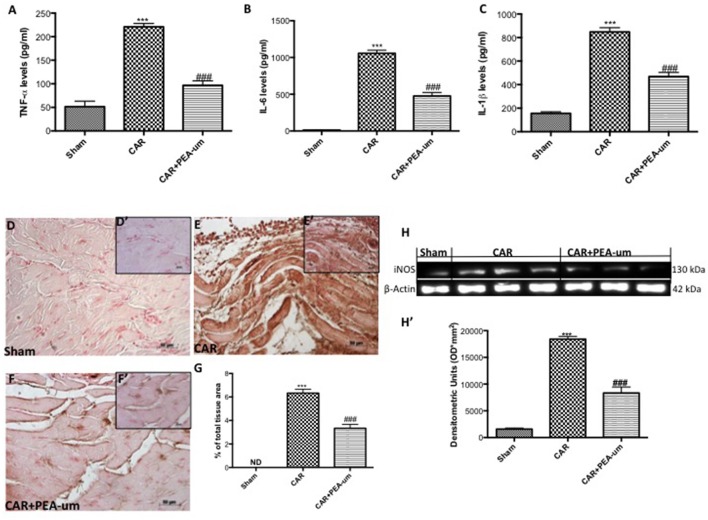
Effect of oral PEA-um on CAR-induced cytokine release, nitrotyrosine formation, and iNOS expression in rat paw tissue. A significant increase of TNF-α (A), IL-6 (B), and IL-1β (C) levels was detected in paw exudates after intraplantar injection of CAR into the rat hind paw. Oral treatment with PEA-um (10 mg/kg) significantly reduced levels of all three cytokines. Immunohistochemical staining for nitrotyrosine was positive in paw tissue sections from CAR-injected rats (E,E',G), as compared to sham animals (D,D',G). The intensity of nitrotyrosine staining was significantly reduced after oral treatment with PEA-um (F,F',G). A significant increase of iNOS expression was observed in paw tissue from CAR-injected rats (H,H'), as compared to sham-treated rats (H,H'). Oral treatment with PEA-um significantly reduced iNOS expression (H,H'). A representative blot of lysates obtained from five animals for each group is shown, and densitometric analysis of all animals is reported. The figures are representative of at least three independent experiments and for all animals from each group. Values are means ± SEM of five animals for each group. ###P < 0.001 vs. CAR; ***P < 0.001 vs. sham.